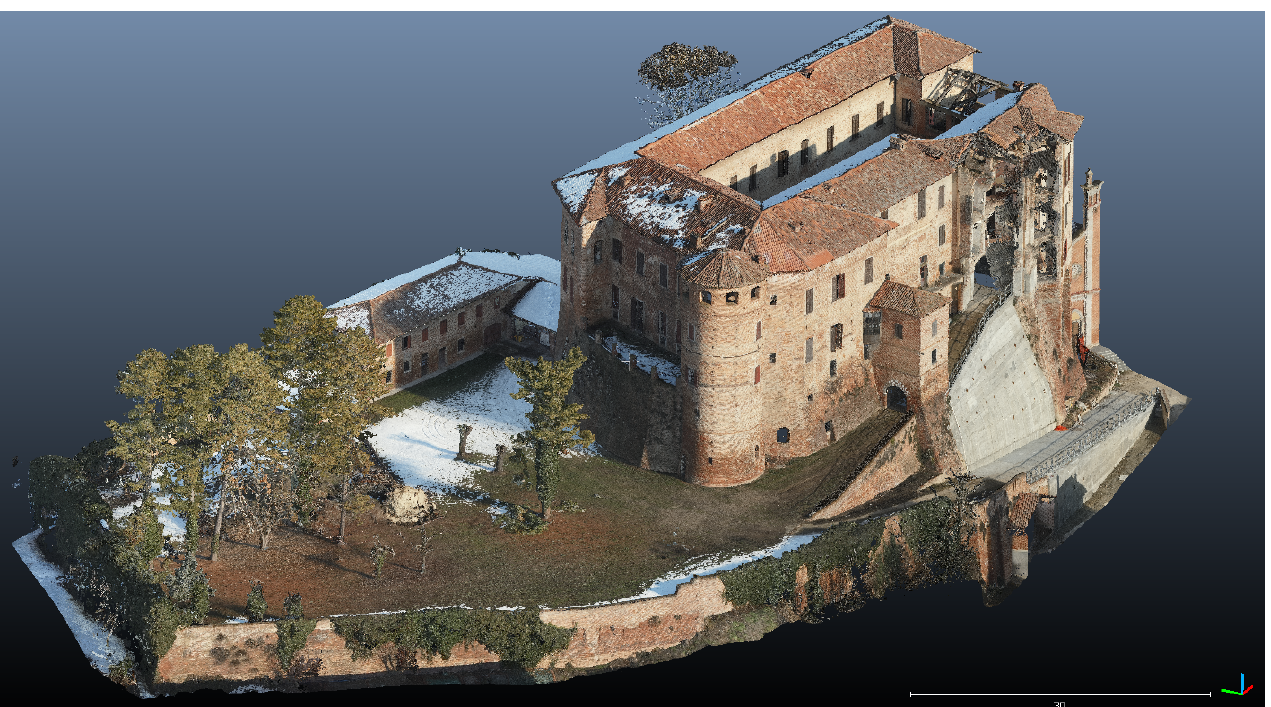
Figure 6. Photogrammetric project: oriented pictures, flight schemas, and positioning.